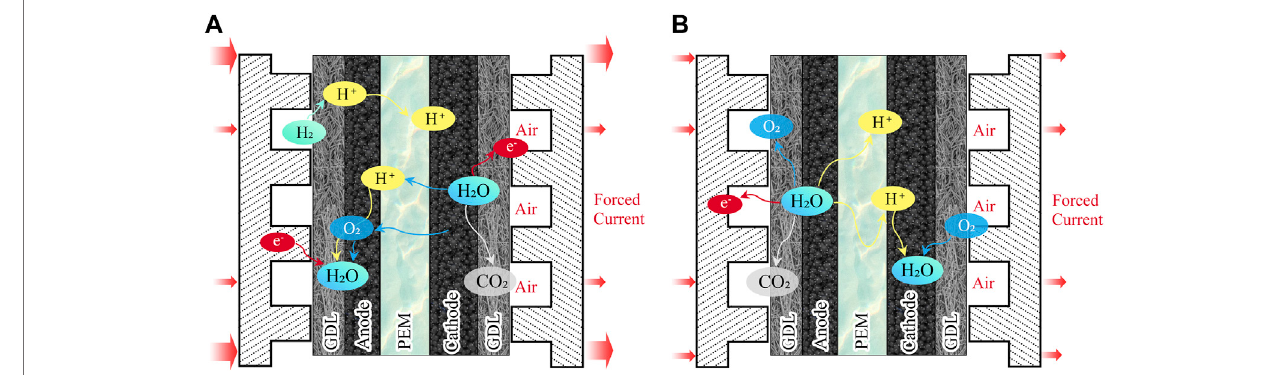
FIGURE 1 | Difference between local H 2 starvation and overall H 2 starvation.